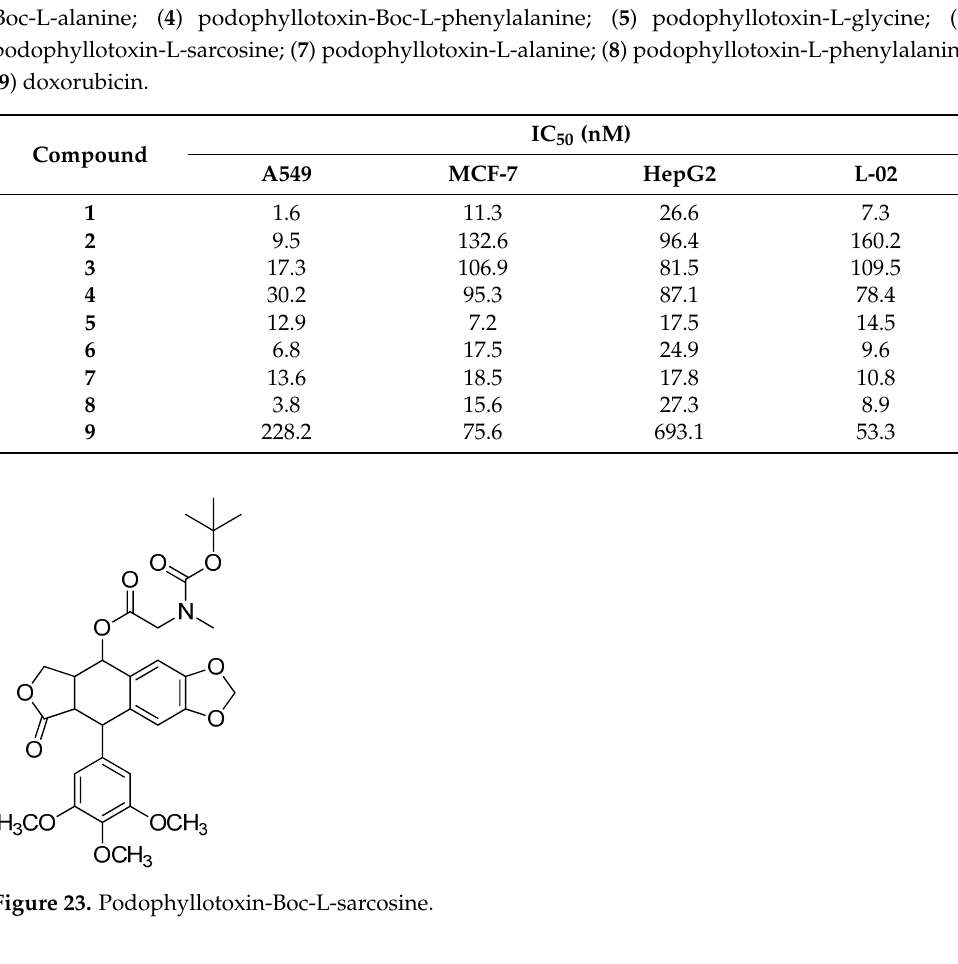
Table 12. Cytotoxic activity of podophyllotoxin–amino acid conjugates in vitro (IC 50 , nM). ( 1 ) Pod- ophyllotoxin-Boc-L-glycine; ( 2 ) podophyllotoxin-Boc-L-sarcosine; ( 3 ) podophyllotoxin-Boc-L-